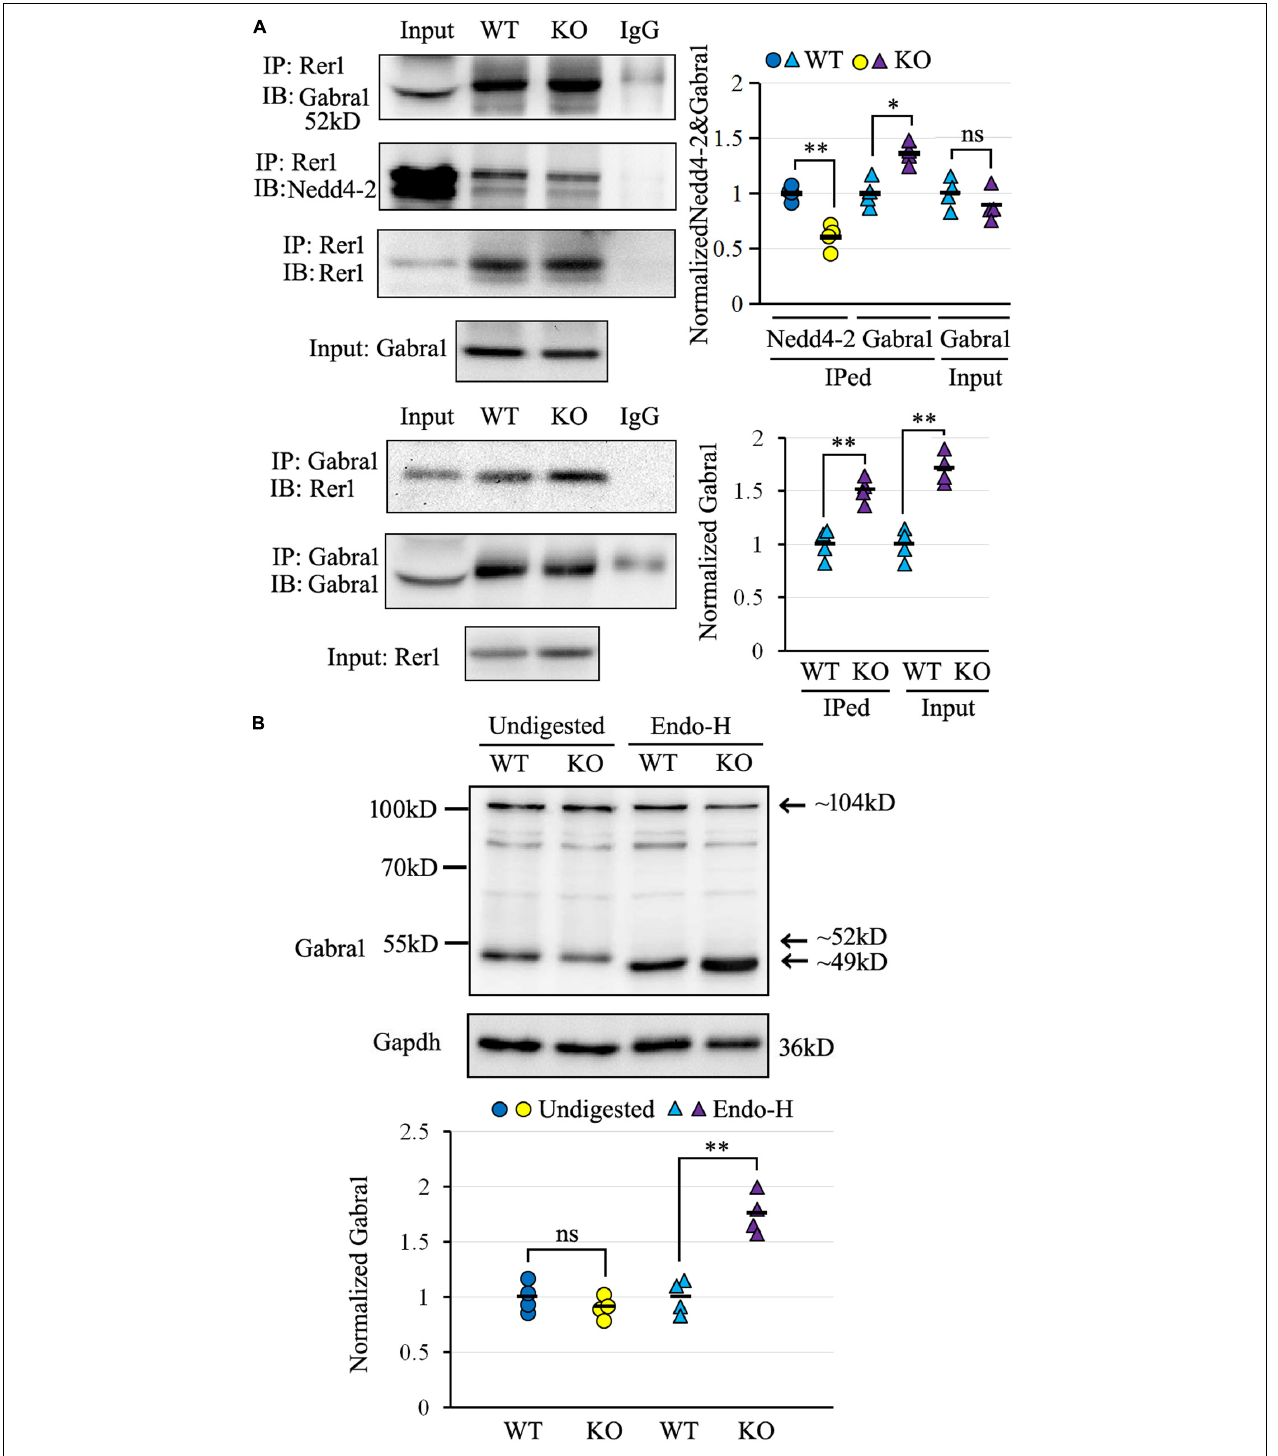
FIGURE 6 | The α 1 subunit of GABA A receptor (Gabra1) interacted with Rer1 and was retained in ER more heavily in Nedd4-2 + / − (KO) mice than wild-type (WT) control. (A) Co-immunoprecipitation analysis for the interaction of Rer1 with Gabra1 and Nedd4-2 in mouse brain lysates ( n = 4 in each group). ∗ P < 0.05, ∗∗ P < 0.01 compared with WT controls by Student’s t -test. (B) Western blotting analysis of Gabra1 in the brain lysates with or without Endo-H digestion ( n = 4 in each group). The Endo-H digested bands represent the ER retention of Gabra1 by removing the ER-modified high mannose N-linked carbohydrates and reducing the molecular weight (around 49 kD) from the monomer (around 52 kD) as well as a possible dimer (around 104 kD). ns, not significant, ∗∗ P < 0.01 compared with WT controls by Student’s t -test.